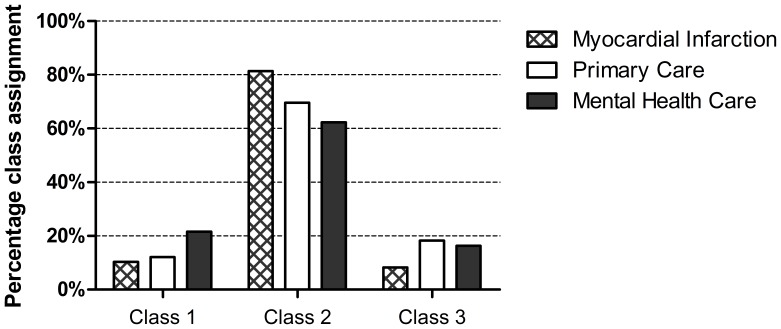
Percentage of class assignment for depressed myocardial infarction, primary care and mental health care patients.N.B. Class 1: Severe, Class 2: Low cognitive – high sadness, Class 3: Low cognitive – high anhedonia.